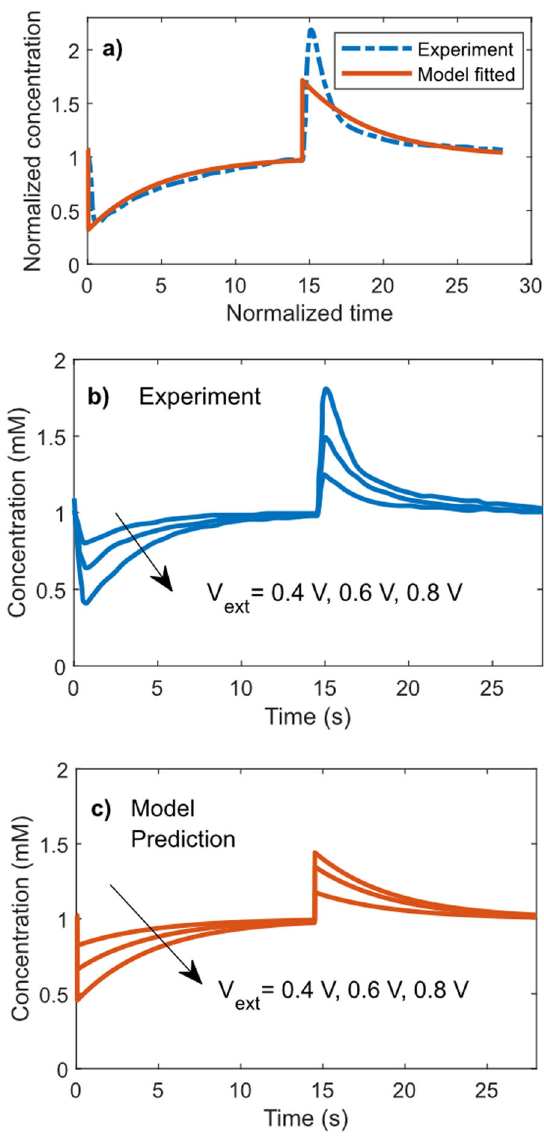
Fig. 2 The ef fl uent ion concentration over time for a fl ow- between CDI cell. The ef fl uent concentration was extracted from ref. 51 . The ion concentration was normalized w.r.t. the inlet concentration, whereas the time was normalized to the diffusion time scale following Hemmatifar et al. 51 . The in fl uent concentration was 20 mM KCl and the fl ow rate was 0.42 mL min − 1 . a The LDL model was fi tted to the ef fl uent concentration data at an applied voltage of 1 V. b The experimental data for operations with 0.4 V, 0.6 V, and 0.8 V. c The model predictions, based on the fi tting in a , for operations with 0.4 V, 0.6 V, and 0.8